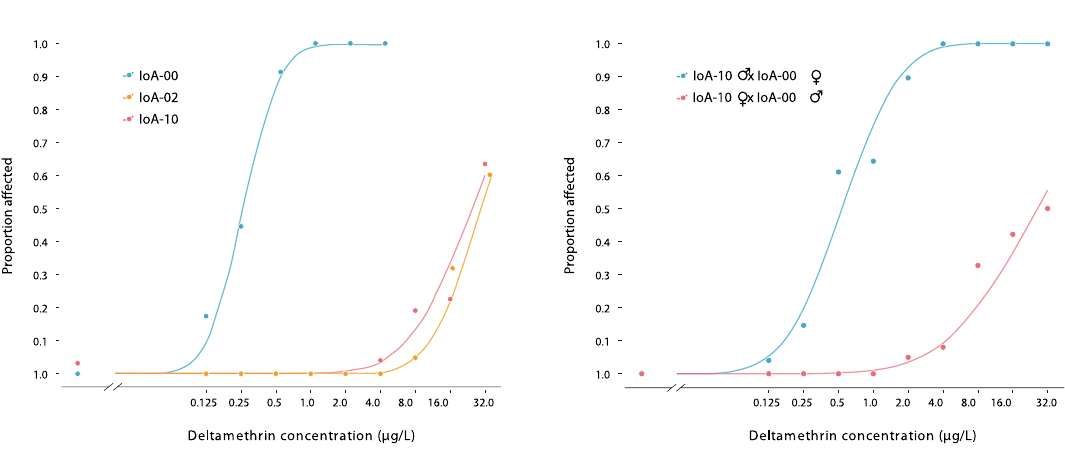
Figure 2. Traditional deltamethrin bioassay with L. salmonis first filial (F1) progenies derived from parental (P0) crosses of different gender-strain orientations. Median effective concentrations EC 50 [µg/L] and 95% confidence limits: IoA-10 = 24.73 (15.06–34.39), IoA-00 = 0.25 (0.20–0.30), IoA-02 = 25.95 (17.98–33.92), F1: IoA-10 dam x IoA-00 sire = 26.10 (11.46–40.75), F1: IoA-10 sire x IoA-00 dam = 0.55 (0.41–0.70). Bioassays involved exposure (30 min) to deltamethrin, followed by recovery in seawater (24 h) and rating of lice as normal or affected. Dose response relationships were established for F1 females and males combined as sex differences were not significant (P > 0.05). Raw data are provided in Supplementary Data